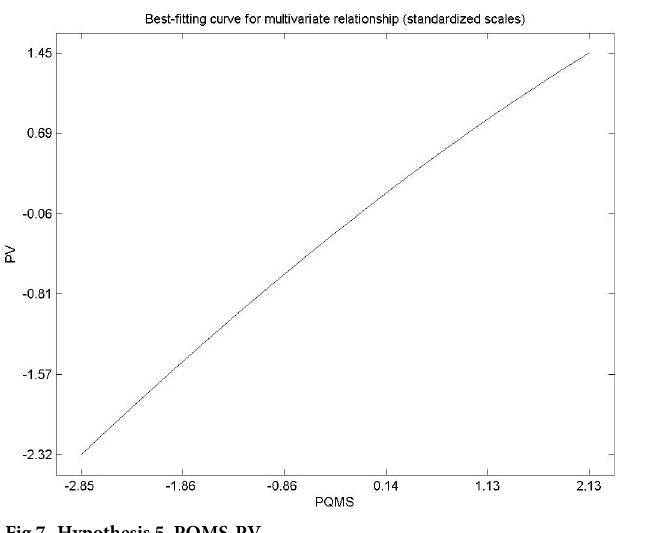
Fig 7. Hypothesis 5,